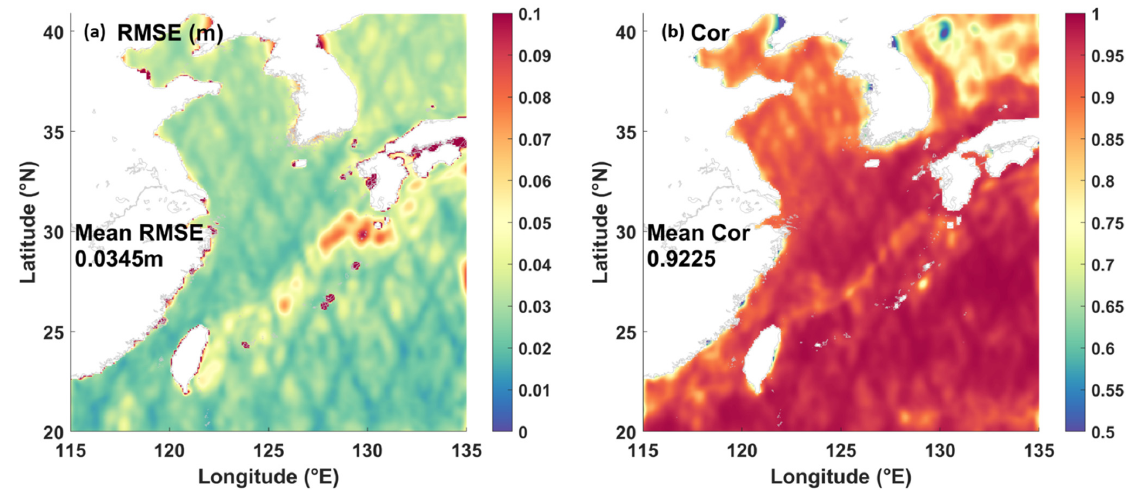
Figure 5. OSSE 2-DVar dataset ( a ) RMSE and ( b ) correlation.